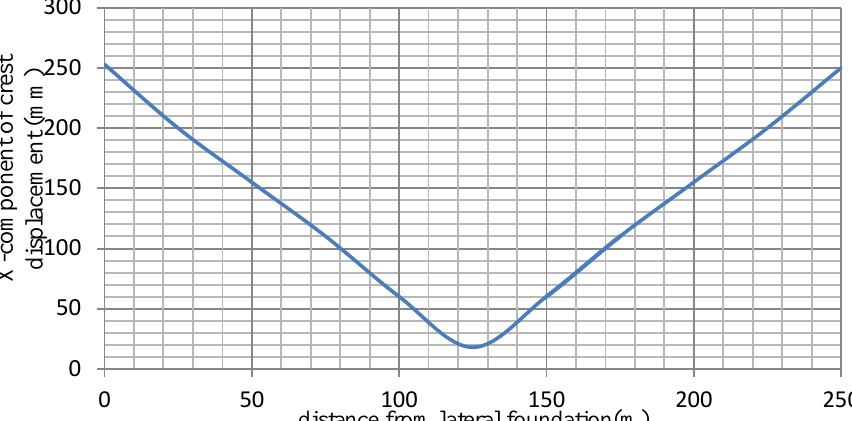
Fig. 4. The displacement of the dam’s crest in the direction of the dam body (x-direction)(mm) versus the distance from the sidewall (m).